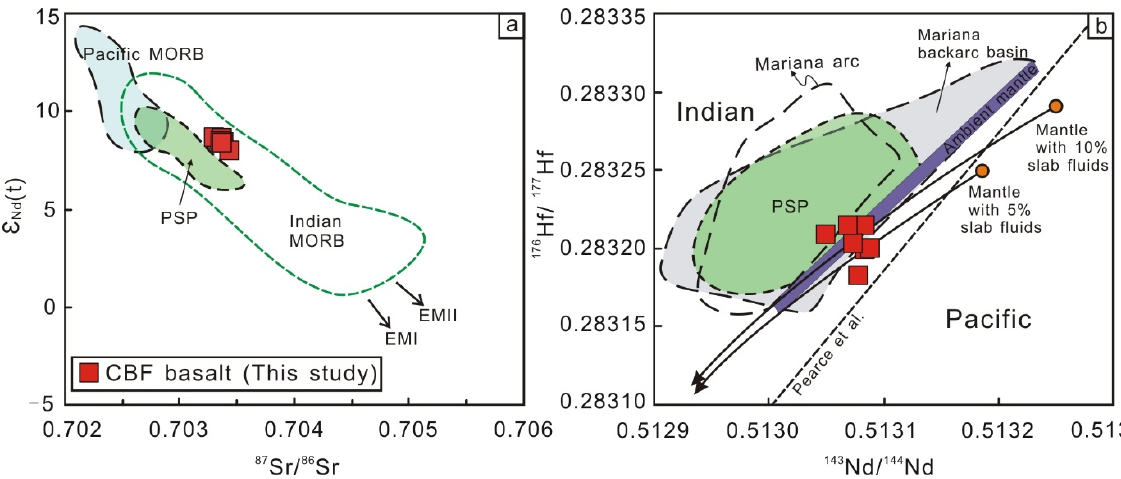
Figure 5. ( a ) Binary plot of ε Nd (t) vs. 87 Sr/ 86 Sr(i) for basalts from CBF in the WPB (modified after Reference [30]). ( b ) Hf–Nd diagram (modified after References [27,31]) used to highlight the mantle heterogeneities beneath the WPB. The Hf–Nd isotopic composition of the investigated basalts is explained as a mixing array between the ambient mantle and a 60:40 bulk mixture between the subducted (altered) oceanic crust and overlying sediments (ODP, Site 801), as in Reference [32]. The red diamonds entitled “mantle with 10% slab fluids” and “mantle with 5% slab fluids” represent an averaged composition of a pre-subduction mantle (i.e., prior to any slab fluid addition). Data for the Mariana arc lavas are from References [33–35]. Data for the Mariana back-arc basin lavas are from References [36–38].